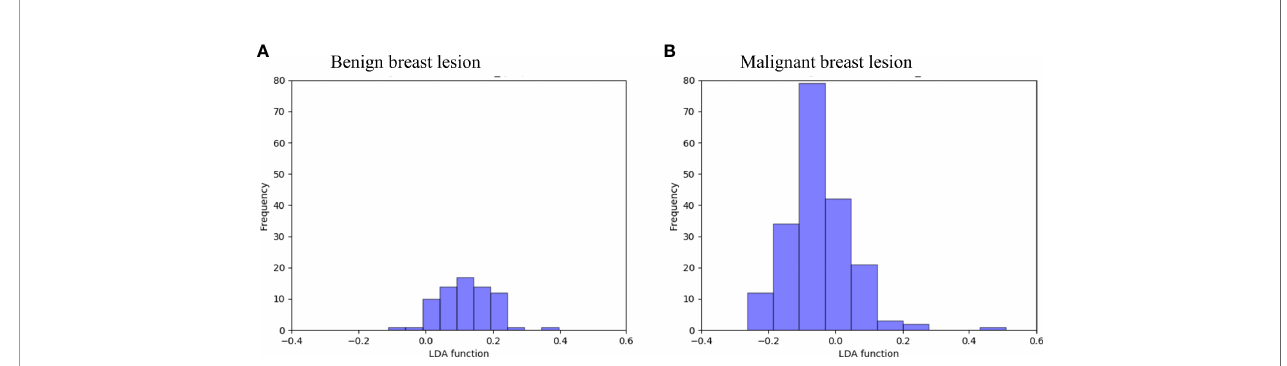
FIGURE 4 | Examples of the 100 data analysis training cycles. Distribution of the direct LDA function determining benign and malignant breast lesions illustrates a promising performance of the GBDT + LDA models. GBDT, gradient boosting decision tree; LDA, linear discriminant analysis. (A) Distribution of the LDA function determined for the benign breast lesions for one cycle; (B) distribution of the LDA function determined for the malignant breast lesions for